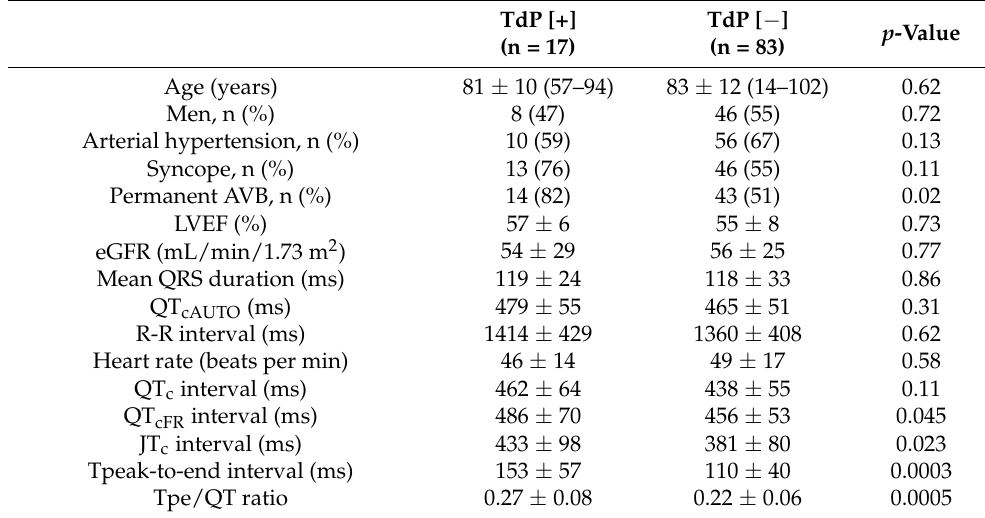
Table 1. Characteristics of patients with TdP.